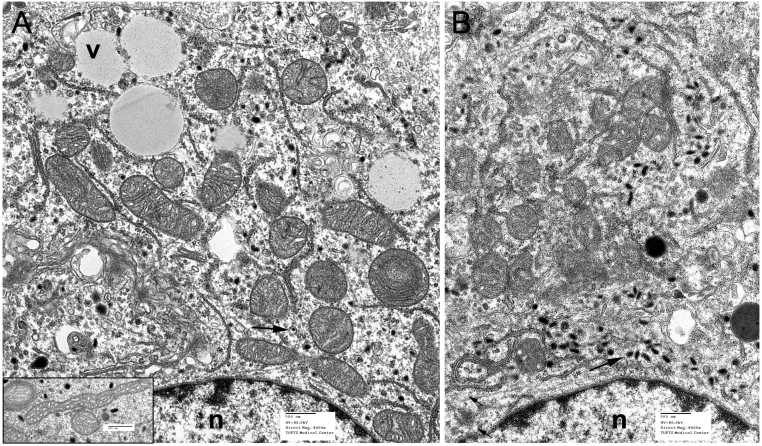
Electron micrographs of RS0 (A) and RS1/2 xenografts (B). Arrows indicate neuroendocrine secretory granules; v, cytoplasmic vacuoles; n, nuclei. Characteristic features of RS0 are cytoplasmic vacuoles and sparse, often tiny secretory granules. In contrast, RS1/2, which is not SDH-deficient, has larger secretory granules and lacks cytoplasmic vacuoles. Inset at left shows elongated mitochondria with tubular cristae that were seen in some RS0 cells.